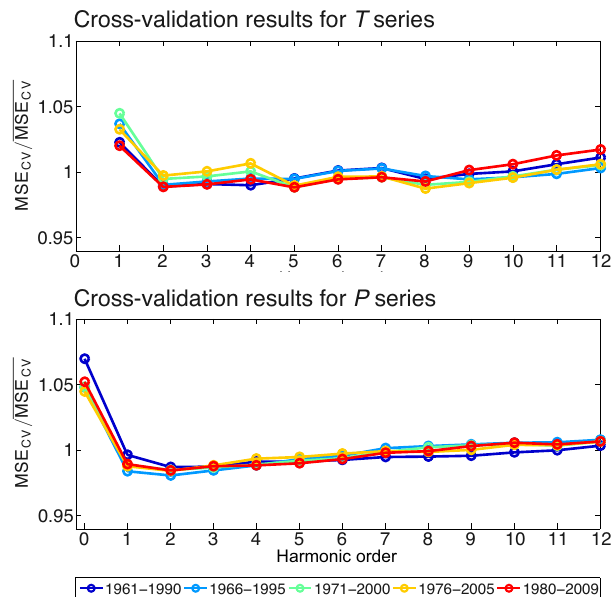
Fig. 3. Mean over all station’s MSE CV of harmonic models with increasing harmonic order (HO 1 to HO 12) for observed daily T (top) and Box-Cox transformed P (bottom) series at Swiss climate monitoring stations (see Fig. 1). Results of five 30yr periods are shown in different colours. The MSE CV have been normalised by the mean MSE CV for display reasons. In the case of T , the MSE CV of HO 0 is much larger compared to higher order harmonic models and is therefore not shown.